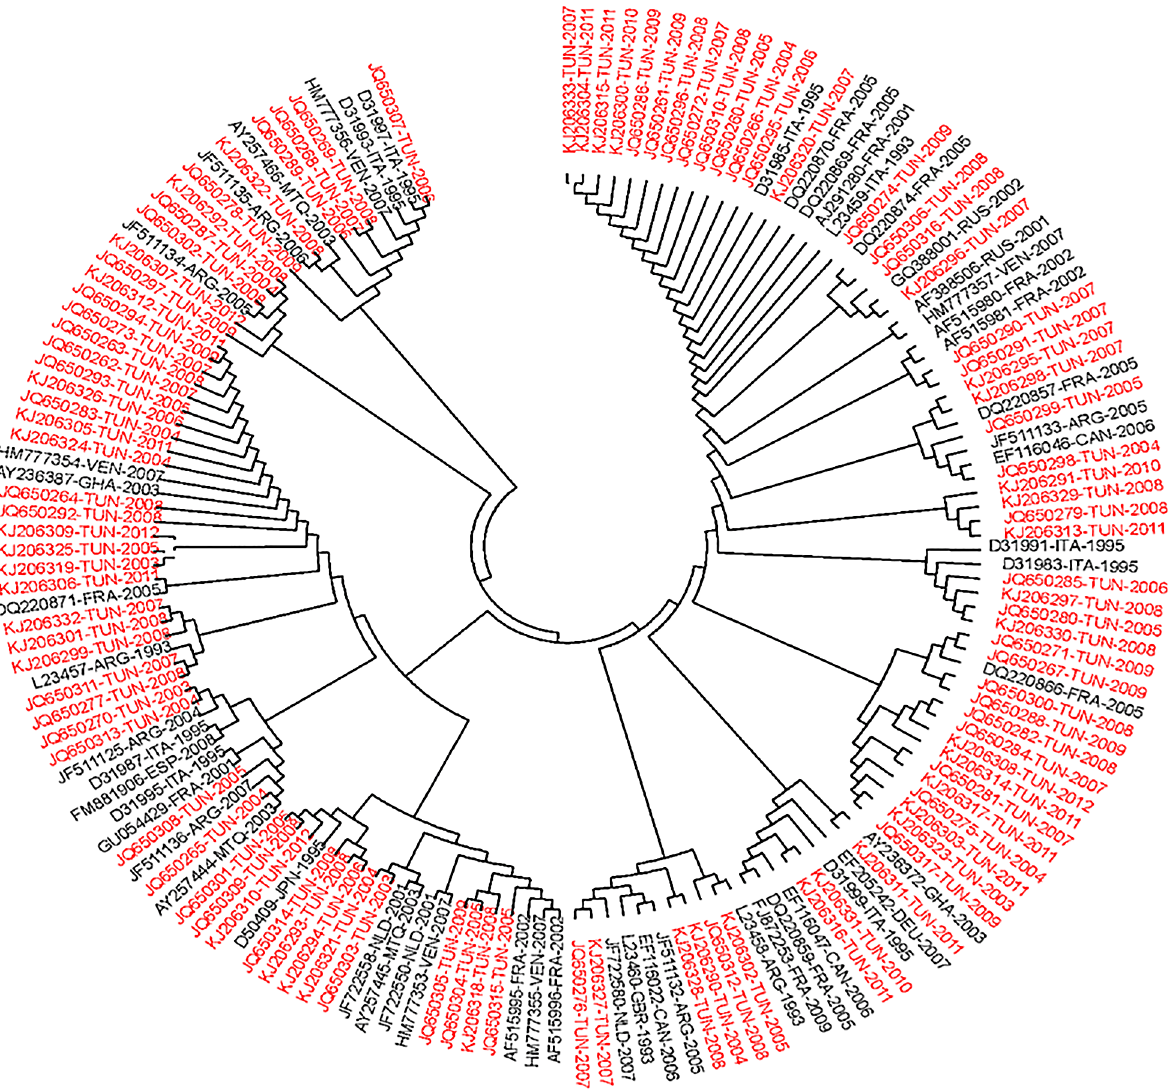
Fig 1. Phylogenetic analysis of isolates from subtype 2c. Phylogenetic analyses were performed using the Maximum Composite Likelihood method included in the MEGA package (version 5.1). The reliability of the phylogenetic constructions was estimated by bootstrap analysis with 1000 pseudo replicate data sets. The tree is based on the analysis of a 222-nucleotide-long fragment in the NS5B region (nucleotides 8316 to 8537 according to the H77-1a prototype strain, AF009606). It includes the 102 studied Tunisian sequences (in red) and 53 HCV-2c field sequences from other countries (in black). All the sequences were indicated by their Accession Numbers followed by the country code and the collection date. The country codes according to the standard abbreviation are: France (FRA), Martinique (MTQ), Canada (CAN), Italy (ITA), Venezuela (VEN), Ghana (GHA), Russia (RUS), Netherlands (NLD), Spain (ESP), Japan (JPN), Germany (DEU), Argentina (ARG) and United Kingdom